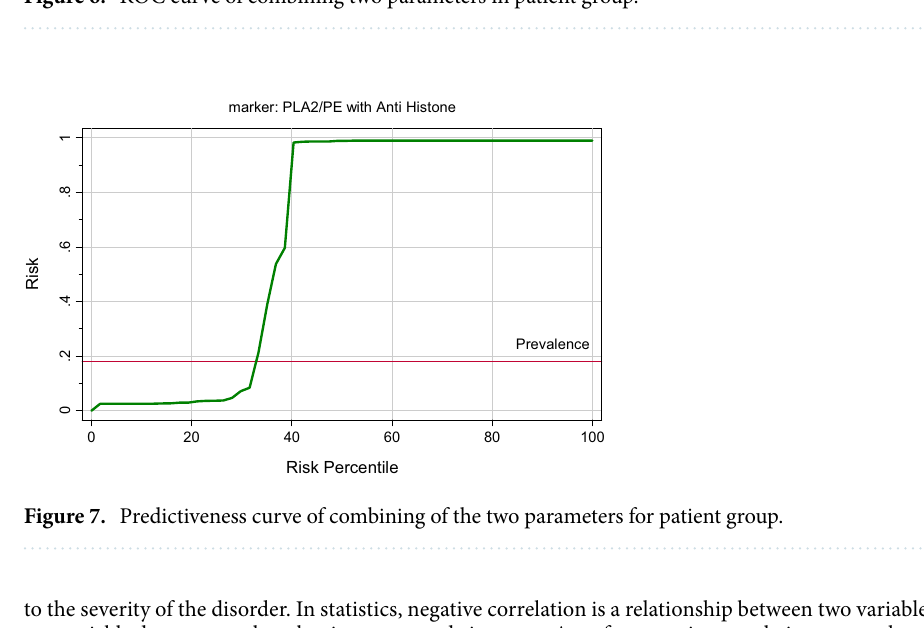
Figure 6. ROC curve of combining two parameters in patient group.